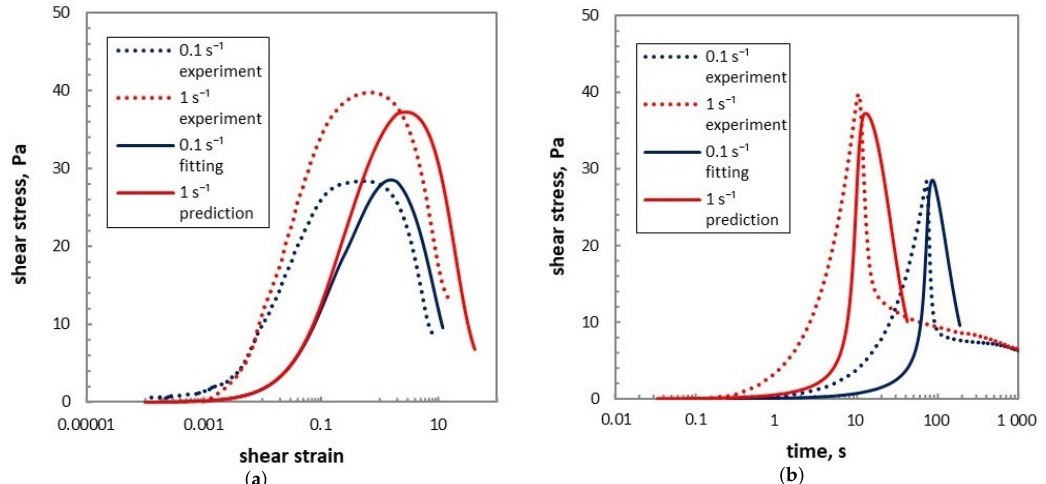
Figure 11. Fitting curves for shear rate ˙ γ = 1 s − 1 and ˙ γ = 0.1 s − 1 of shear stress as a function of shear strain and of time, taking the whole calculation same as in Figure 10, but using the elastic modulus under the assumption of a single network structure by G 0,1 = 0 Pa in Equation (18) and changing value for the remaining network to p 2 = 1: ( a ) shear stress as a function of shear strain; ( b ) shear stress as a function of